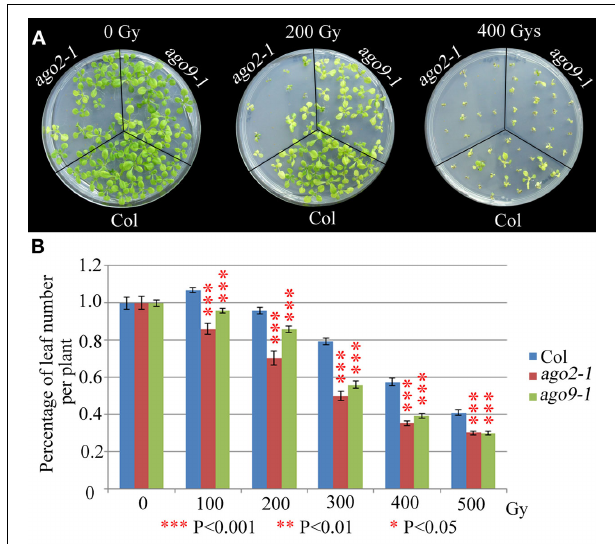
FIGURE 5 | ago2-1 and ago9-1 are hypersensitive to γ -rays. (A) Phenotypes of 14-day-old seedlings ( ago2-1, ago9-1, and Col) after treatment with different radiation doses. (B) Percentage of leaf number per plant after treatment with different radiation doses. Leaf number at each dose was scored and put into relation to the leaf number of the untreated plantlets of the same line. Mean values and standard errors are depicted. Asterisks indicate P -values from t -Student tests: ∗∗∗ P < 0 . 001, ∗∗ P < 0 . 01, and ∗ P < 0 . 05. See Supplementary Table S2 for more details.